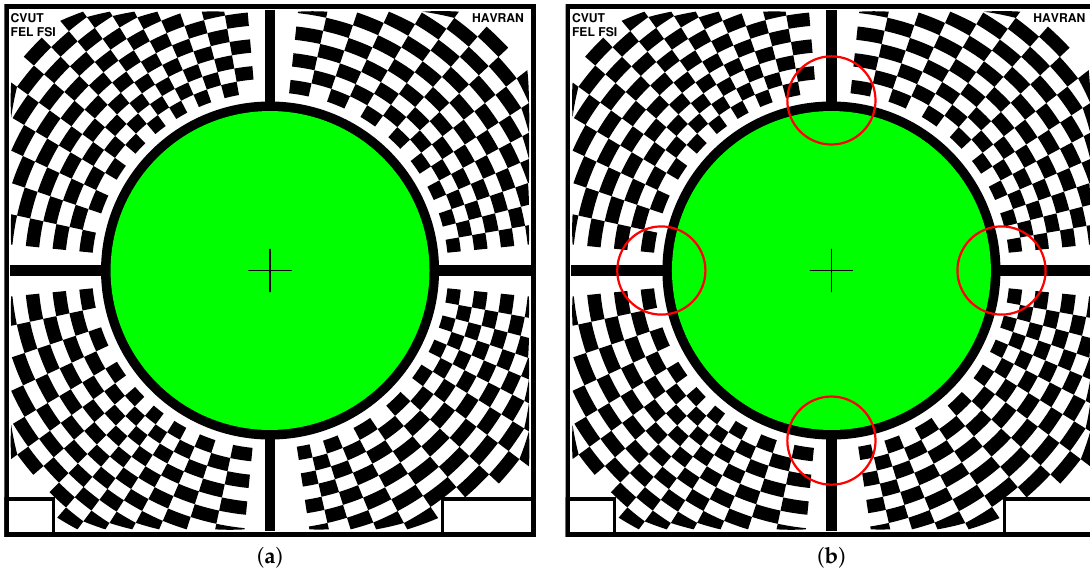
Figure 14. ( a ) Marker sticker design with a 51 mm diameter hole shown by the green colour; the size of marker sticker is 85 85 mm 2 , the angular distribution of chequerboard pattern is intentionally × irregular; ( b ) Red circles mark the regions that allow for visual detection and checking of correctness of acquired images. This enables proper sample orientation in case of any image transformation by camera processing or for incorrect positioning the orientation of the gantry towards the measured